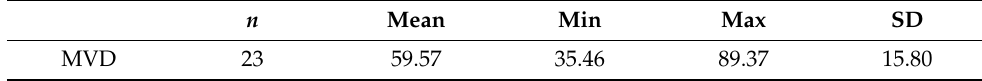
Table 7. Mean MVD at invasive front in the investigated specimens.